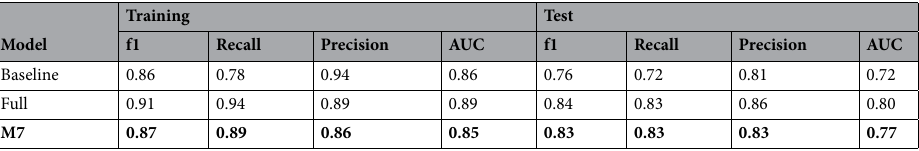
Table 3. Evaluation of predictive models for the predictors of QoL. The “Baseline” and “Full” models use the entire dataset, while “M7” uses the seven most important features that resulted from the “Full” model. The best model is presented in bold. AUC is the Area Under the ROC (Receiver Operator Characteristic) Curve.